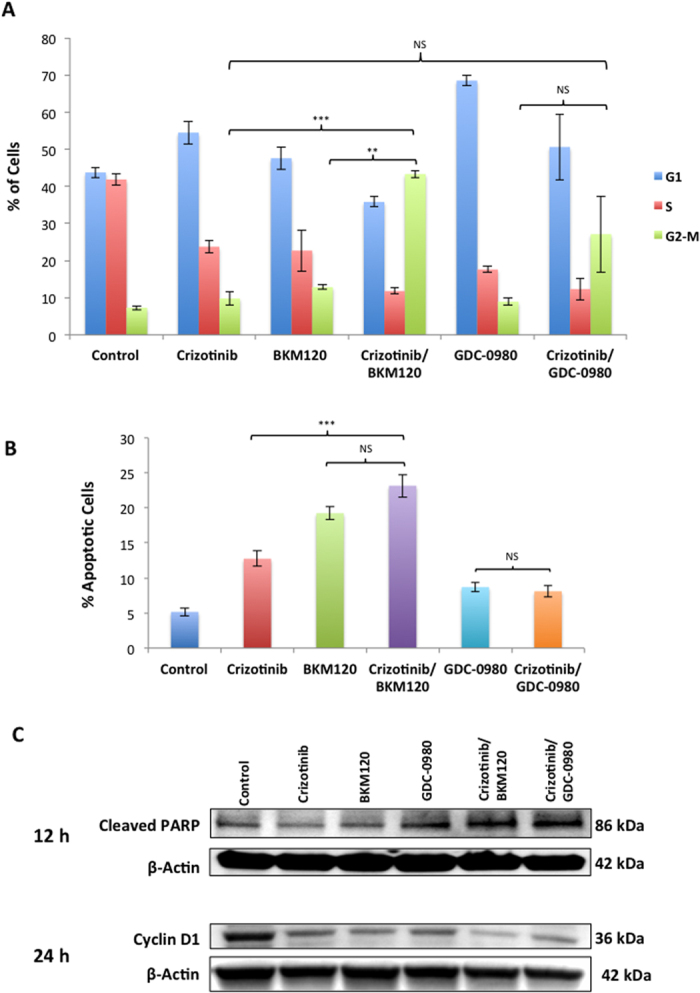
Crizotinib, BKM120, and GDC-0980 alone or in combination induce cell cycle arrest and apoptosis.(A) Summary of the percentage of cells in each cell cycle phase after the treatment of MPM cells with 1 μM crizotinib, 2 μM BKM120, 0.25 μM GDC-0980 alone and in the indicated combinations for 48 h. Data is shown as the % of cells in G1, S and G2-M phases ± SEM. Results were analyzed by ANOVA with Tukey post-test. (NS p > 0.05, *p < 0.05, **p < 0.01, ***p < 0.001). (B) H2596 cells were treated with 1 μM crizotinib, 2 μM BKM120, 0.25 μM GDC-0980 alone and in the indicated combinations for 48 hours then stained with Annexin V-FITC/PI and analyzed by flow cytometry. Results are expressed as the mean percentage of apoptotic cells ± SEM. (C) Cells, were treated with 1 μM crizotinib, 2 μM BKM120, 0.25 μM GDC-0980 alone and in the indicated combinations for 12 h and 24 h. Cell lysates were prepared and immunoblotted for cleaved PARP, cyclin D1 antibodies and actin was used as a loading control.